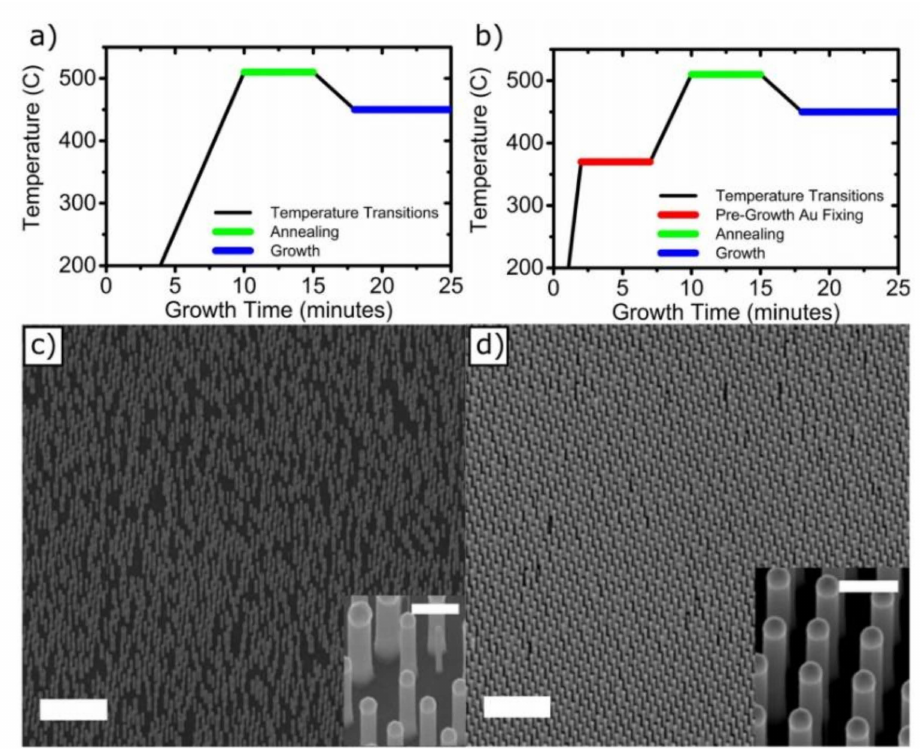
Figure 10. Effect of pre-annealing step in improving the vertical yield and uniformity of ordered InP NW arrays grown by the gold-catalyzed VLS method. The figure reports the process temperature evolutions and scanning electron microscope images of grown samples without including (( a )–( c )) and including (( b )–( d )) a pre-annealing step of the lithographically pre-patterned substrate. The samples were prepared for NW growth by defining 160 nm diameter and 20 nm high Au catalyst particles in periodic arrays with a period of 400 nm using nanoimprint lithography on InP (111)B substrates. Without the pre-annealing step ( a ) the au droplets can split, move and merge with other nanoparticles, causing missing nanowires in the pattern and deviations from the defined positions ( c ). The addition of a pre-annealing thermal treatment, at intermediate temperatures with respect to the growth temperature ( b ), enhances the adhesion of Au catalysts to their position, preventing them from moving across the substrate surface and improving the pattern fidelity ( d ) (Reprinted with permission of Ref.